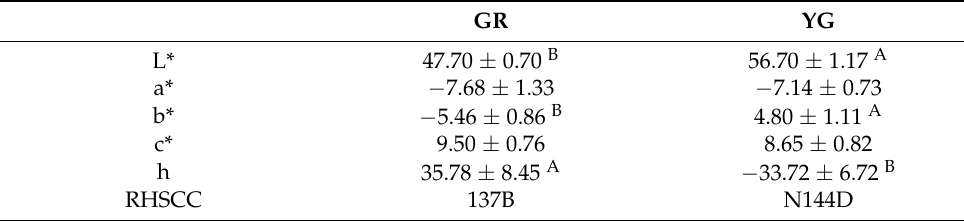
Figure 1. Shape of P. tatarinowii ‘Jinyuyuan’ leaves. ( a ) Comparison of P. tatarinowii ‘Jinyuyuan’ and wild-type plants; ( b ) details of the variegated leaves as they became larger. Table 1. Results of leaf colour determination.